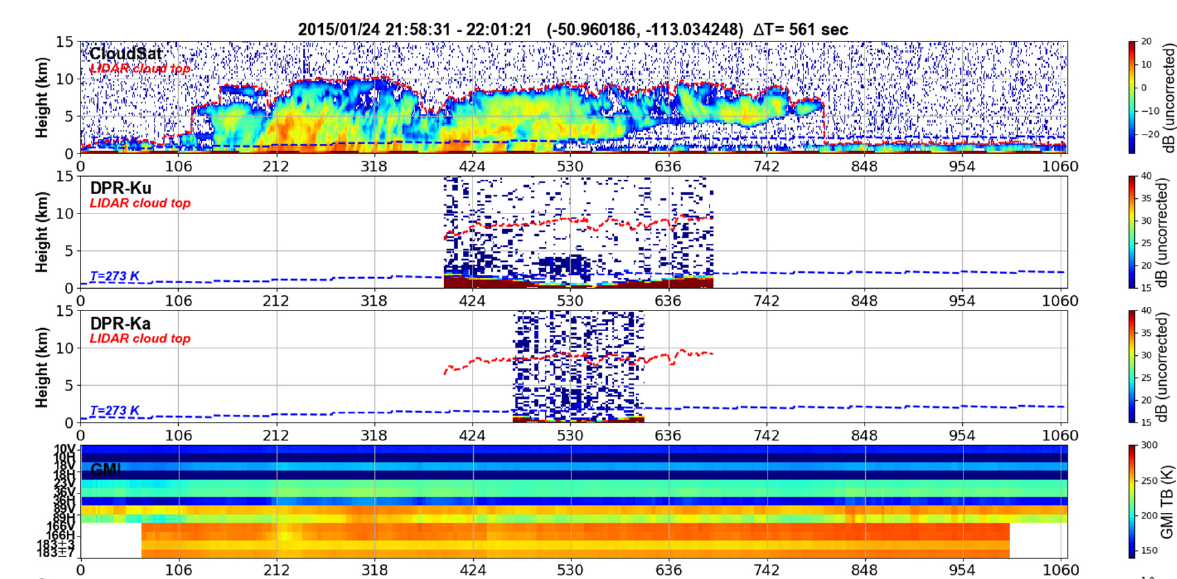
Figure 13. Same as the top four panels of Figure 4, but showing the CloudSat-GPM coincident overpass on 24 January 2015 near 2200 UTC. The top three panels show the (uncorrected for attenuation) equivalent radar reflectivity profile (dBZ) from CloudSat, DPR Ku- and Ka-band MS, respectively, scaled as shown in the color bar. Light precipitation is shown below the sensitivity of the DPR. The fourth panel shows the line-trace of the 13 GMI channels (increasing in frequency from top to bottom), in an image format.